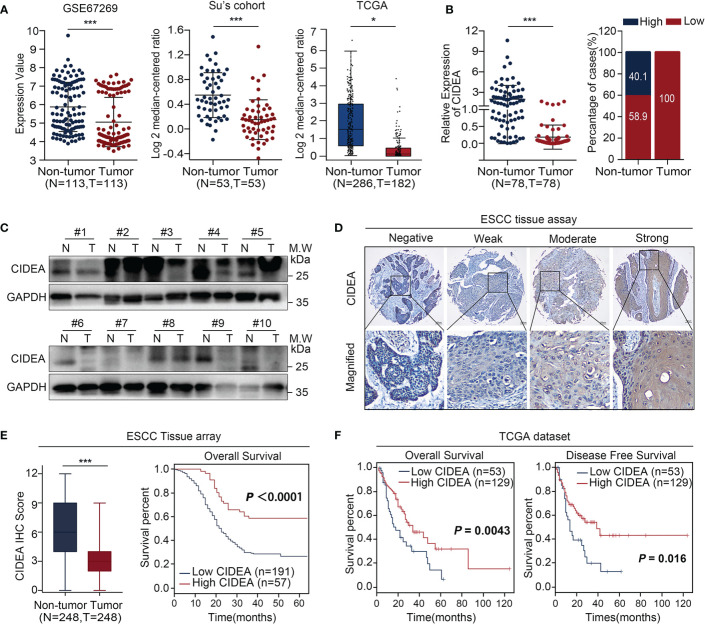
CIDEA expression was downregulated in ESCC, and low expression correlated with poor survival. (A) CIDEA expression was compared between ESCC tumor and normal esophageal samples derived from the GEO, Oncomine and TCGA databases. (B) The mRNA level of CIDEA was detected by qRT-PCR in 78 pairs of ESCC tissues and adjacent non-tumor tissues with β-actin as the internal reference control. CIDEA expression fractions in 78 ESCC tissues and adjacent non-tumor tissues. (C) The protein levels of CIDEA in 10 pairs of ESCC tumors (T) and corresponding normal esophageal (N) tissues were analyzed by Western blotting with GAPDH as the loading control. (D) Representative pictures of IHC staining of CIDEA in an ESCC tissue microarray (n = 248). Scale bars, 100 μm. (E) CIDEA staining scores in ESCC tumors and the corresponding non-tumor tissues (n = 248). (E, F) Kaplan-Meier analysis indicated that the down-regulation of CIDEA was negatively correlated with overall survival (OS) time and disease free survival (DFS) time in ESCC tissue microarray (n = 248) and TCGA dataset (n = 182). Data are presented as the mean ± SD. *P < 0.05; **P < 0.01; ***P < 0.001.